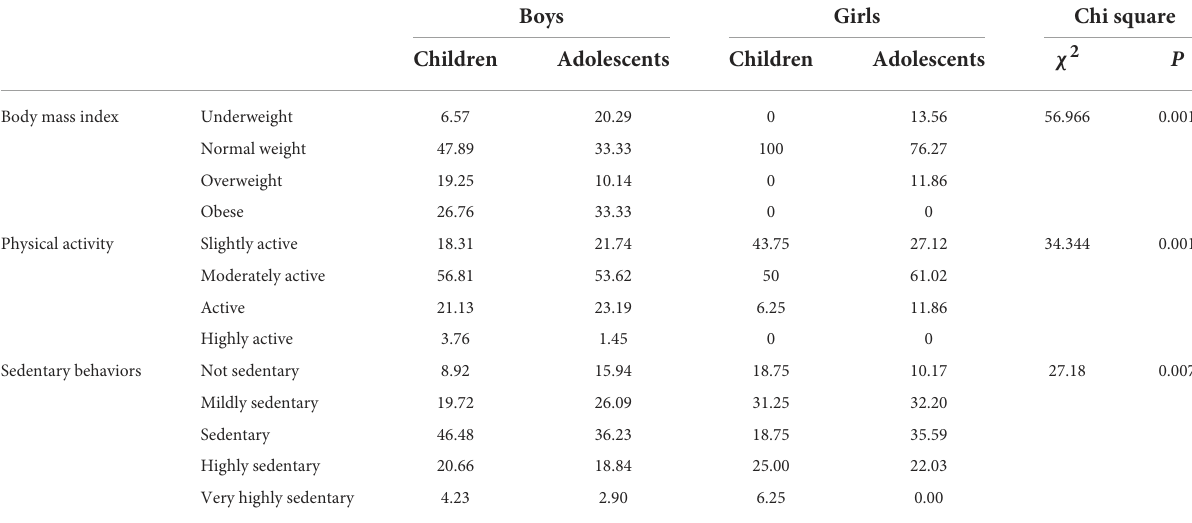
TABLE 2 Prevalence of overweight and obesity, physical activity, and sedentary behaviors among Saudi students stratified by sex and age.